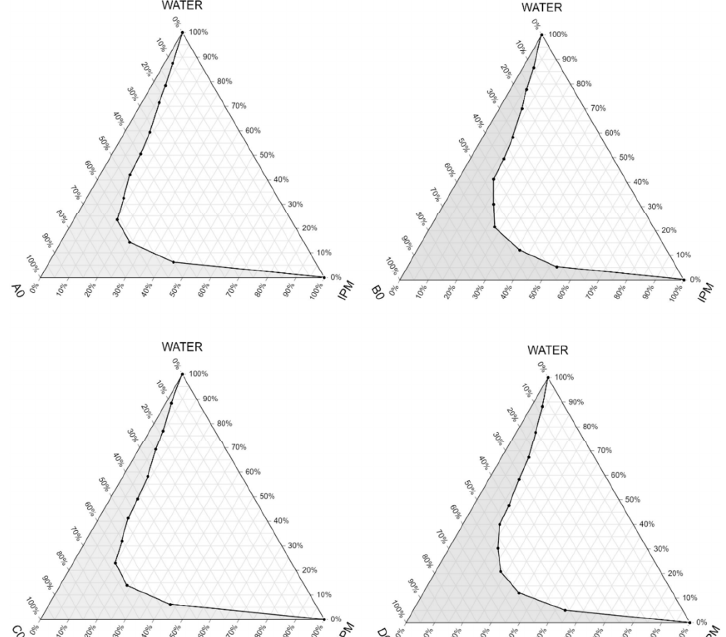
Figure 3. Pseudoternary phase diagrams of the compositions without the active ingredient. (Shaded areas represented the nano/microemulsion regions).